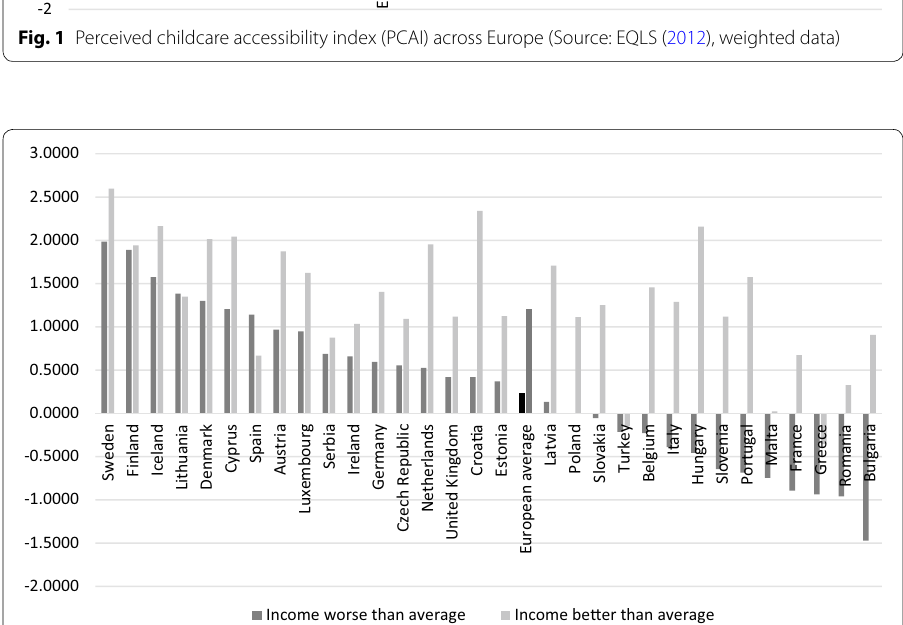
Fig. 1 Perceived childcare accessibility index (PCAI) across Europe (Source: EQLS (2012), weighted data)